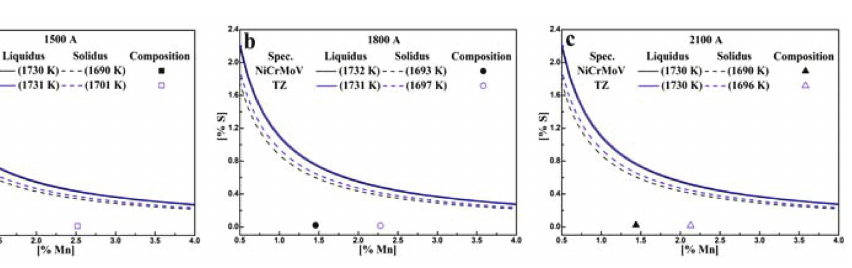
Figure 8: Stability diagram of MnS precipitation in the dual alloy ingot: specimen 1500 A, specimen 1800 A, specimen